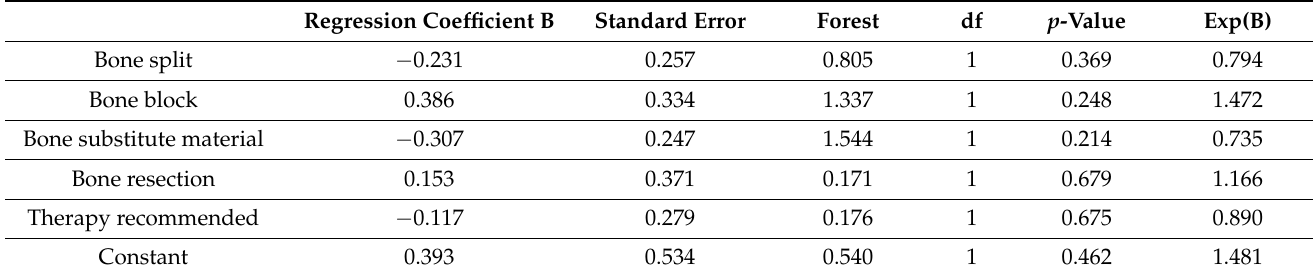
Table 7. Association between the dependent variable “readiness to involvement” (anxiousness vs. interest in implant therapy) and the independent variables “bone split”, “bone block”, “bone substitute material”, “bone resection”, and “therapy recommended” for Case Vignette